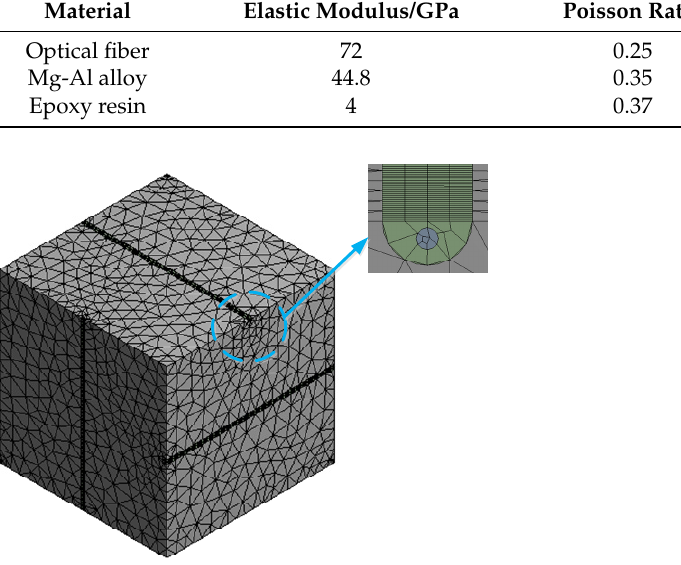
Figure 6. Finite element calculation model.